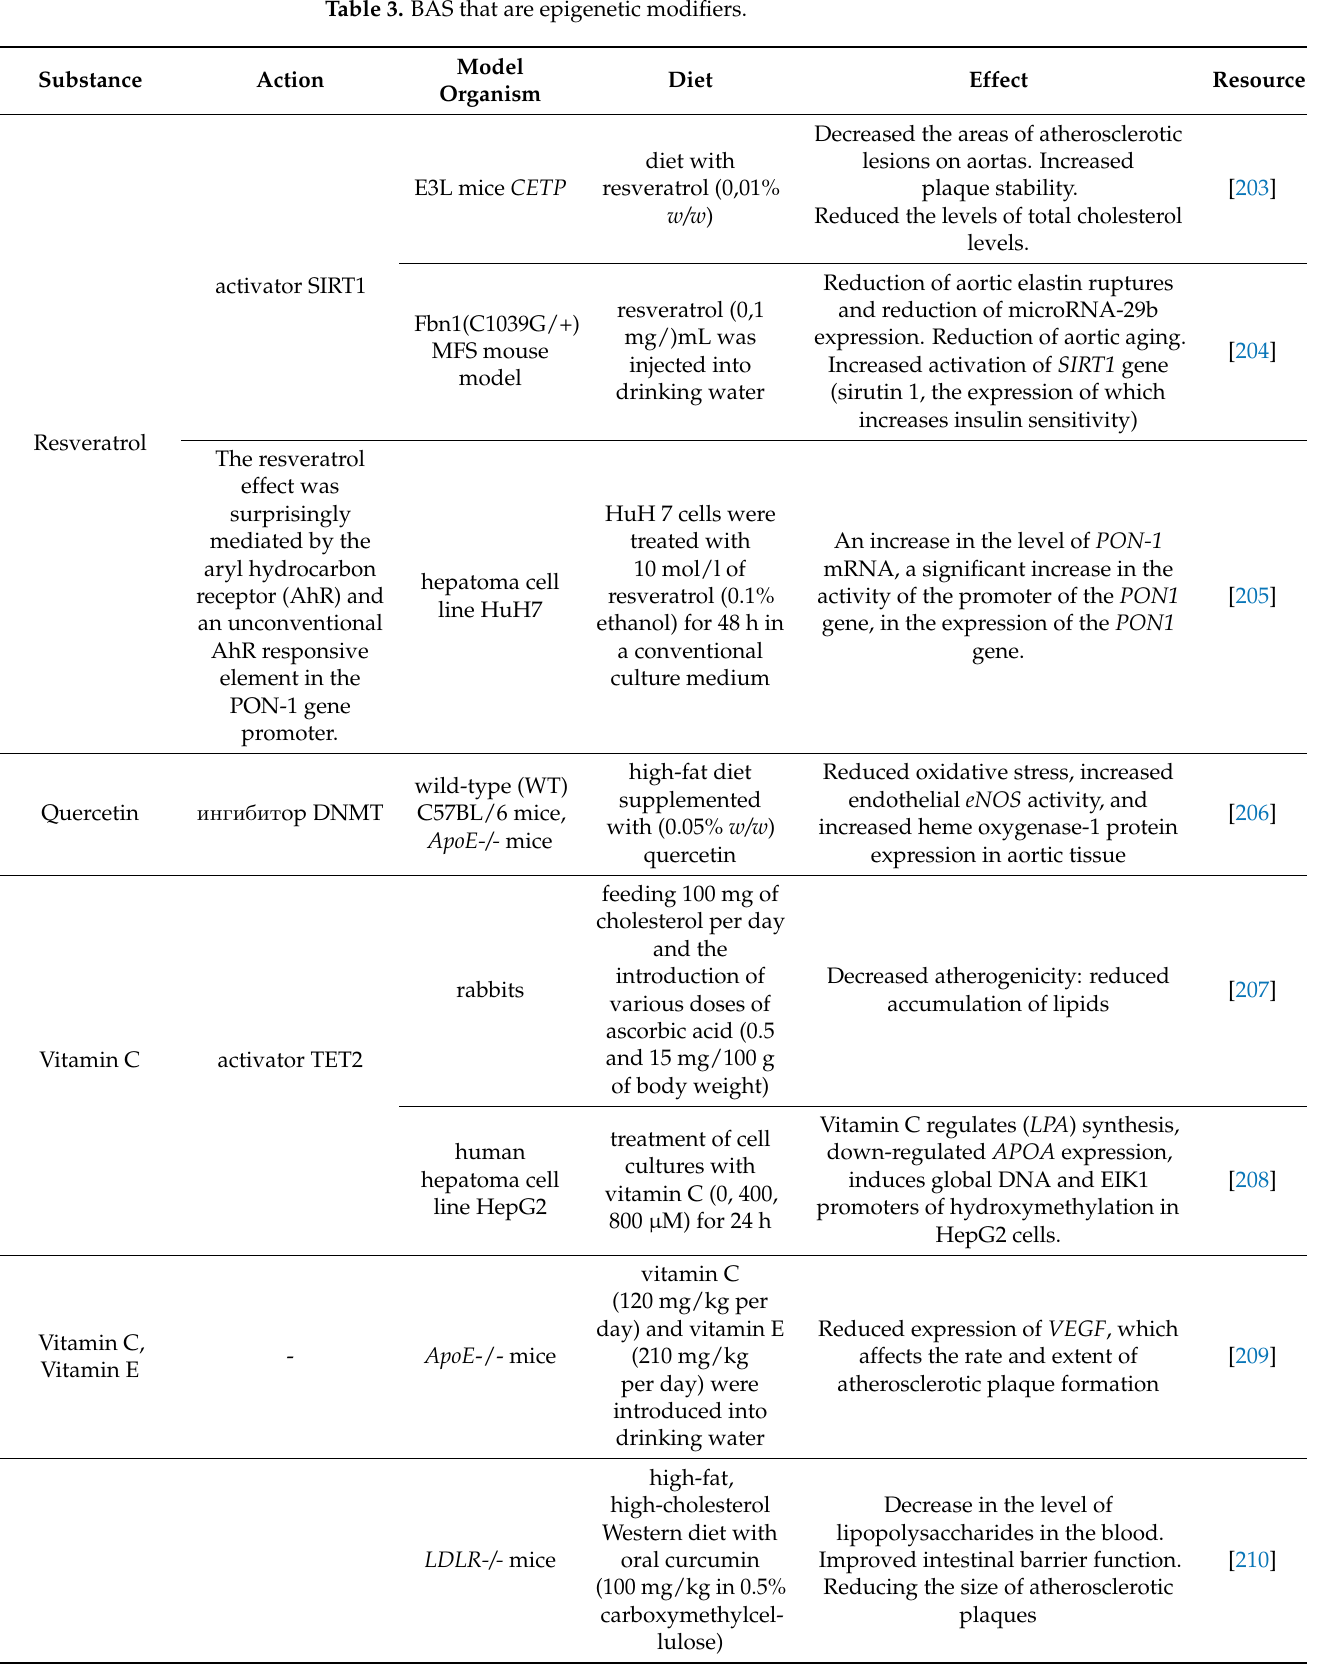
Table 3. BAS that are epigenetic